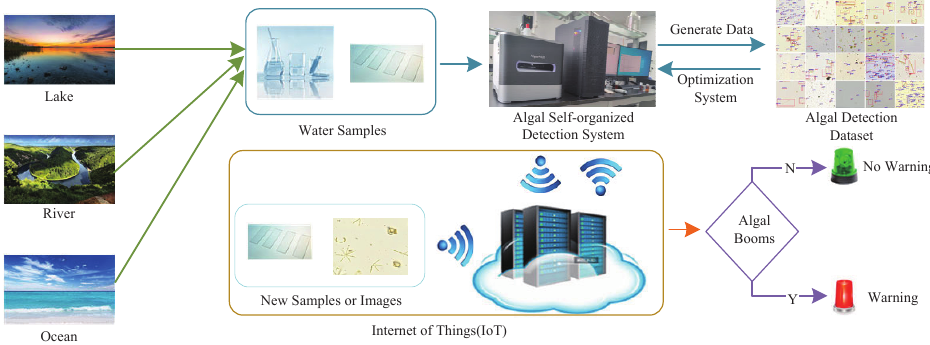
Figure 2. The schematic diagram of the algal self-organized detection system under the